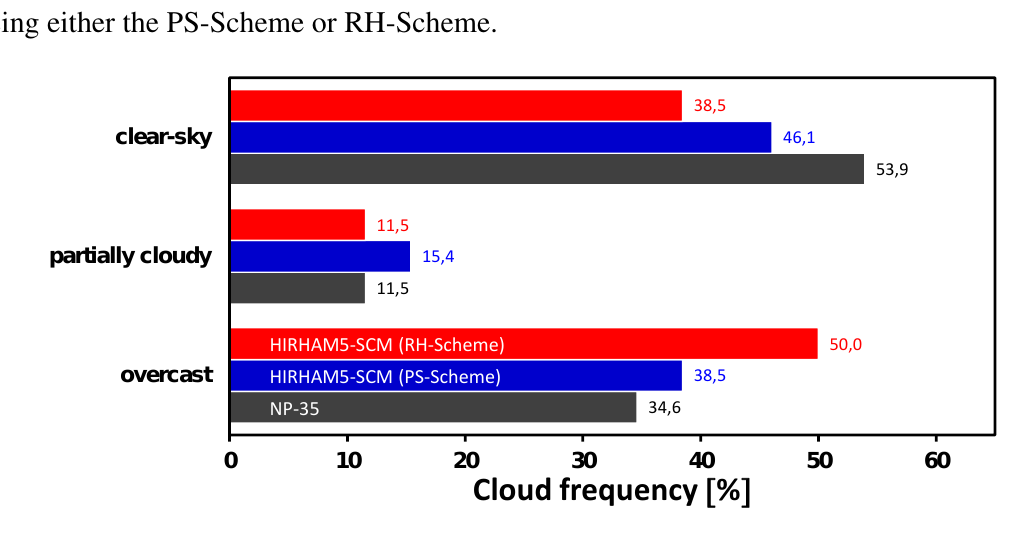
Figure 2. Relative frequencies of clear-sky, partially cloudy, and overcast cases based on